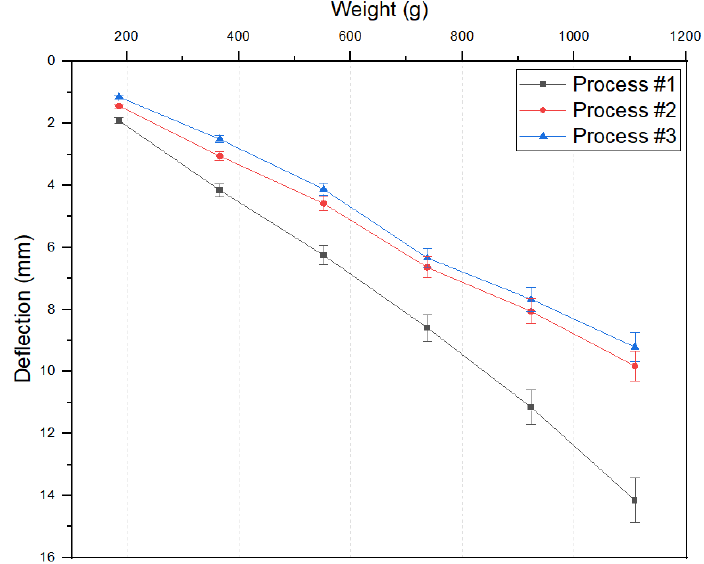
Figure 10. Cantilever test results. Table 6. Bending strength of the CFRP bar produced in each process case.